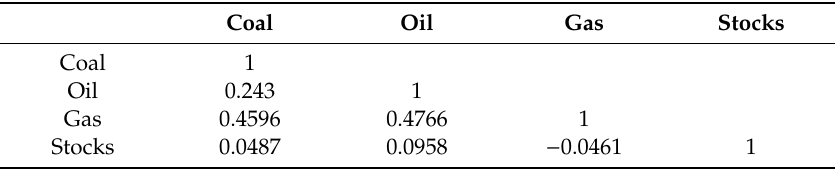
Table 3. Correlations for